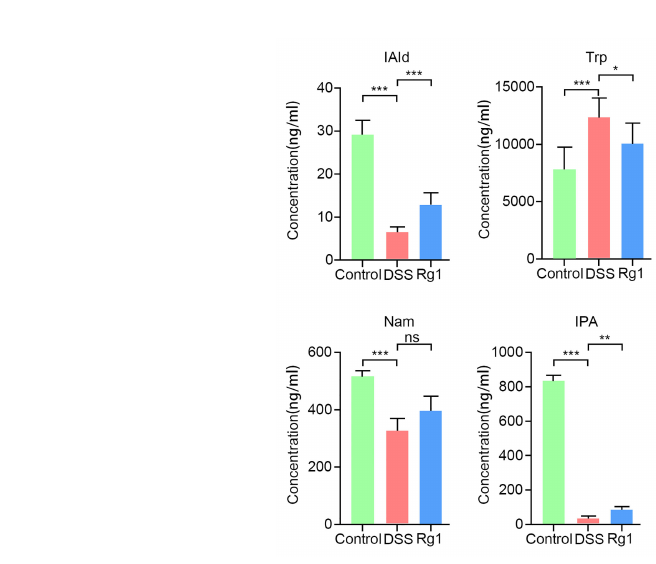
FIGURE 6 | The change of serum tryptophan and its metabolites in all groups. Data are shown as mean ± SD (n=6). P < 0.05 was considered to be statistically signi fi cant. Signi fi cance levels are indicated as *P < 0.05, **P < 0.01, ***P < 0.001, and ns stands for not statistically signi fi